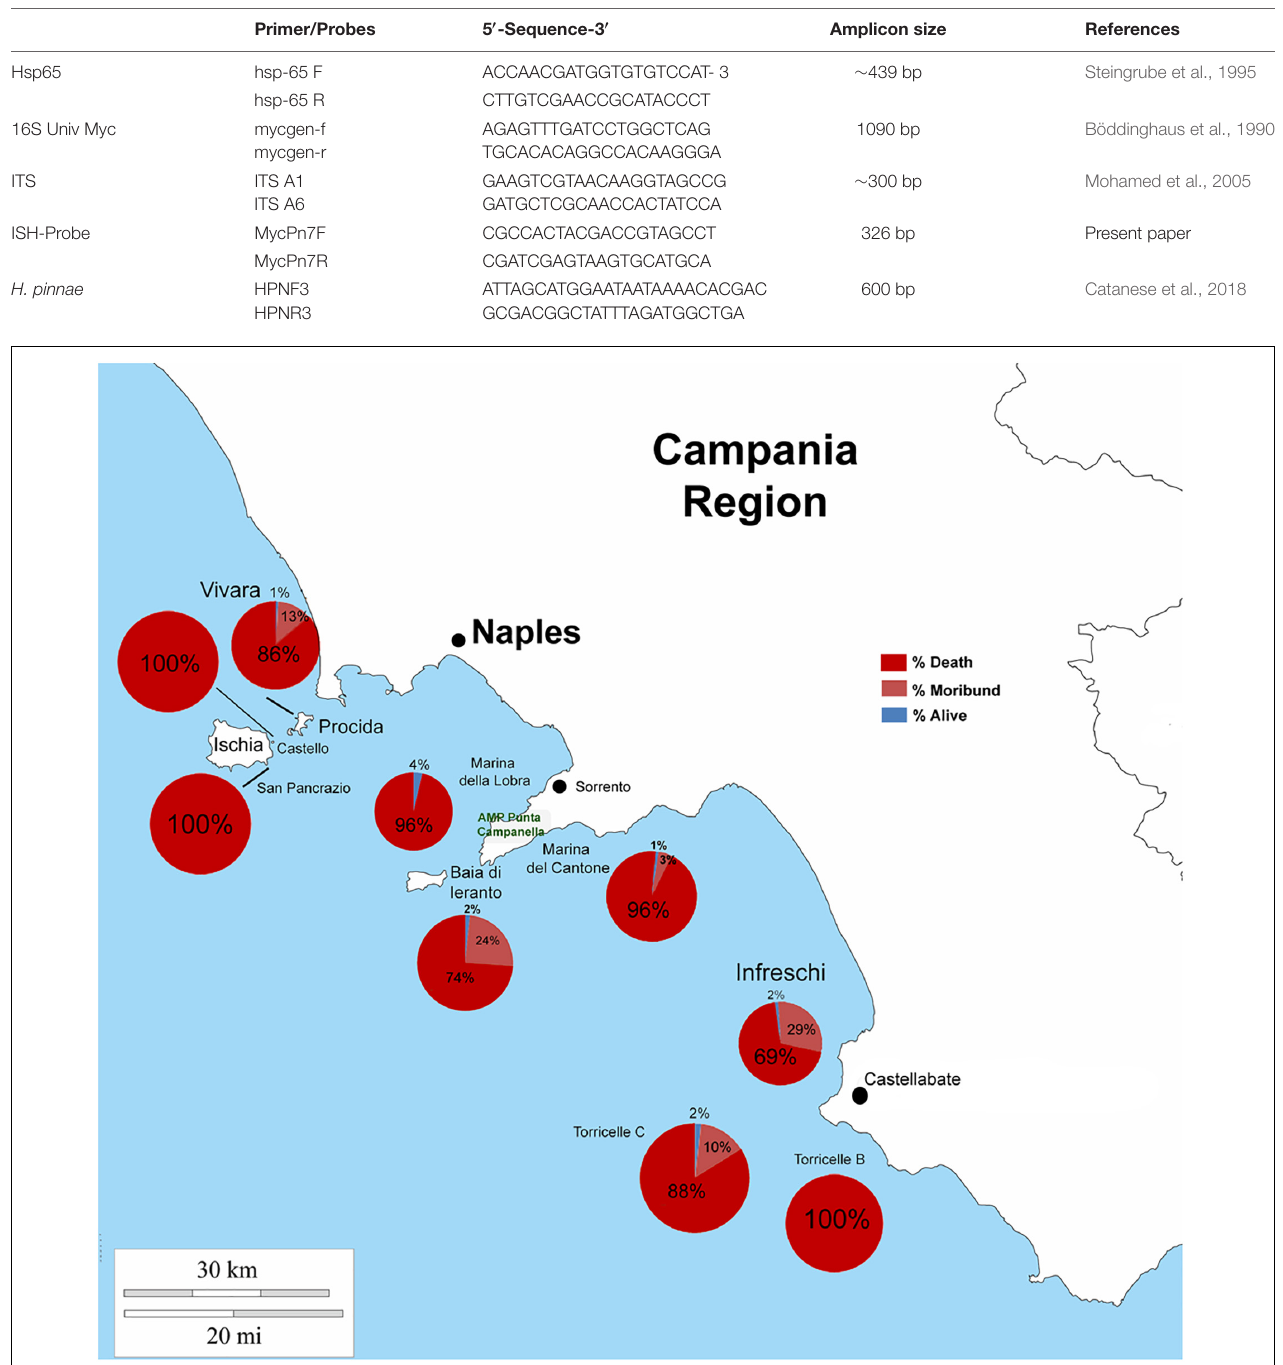
FIGURE 2 | Percentage of death, moribund and survived individuals of P. nobilis in Campania Region in period 2017–2018.